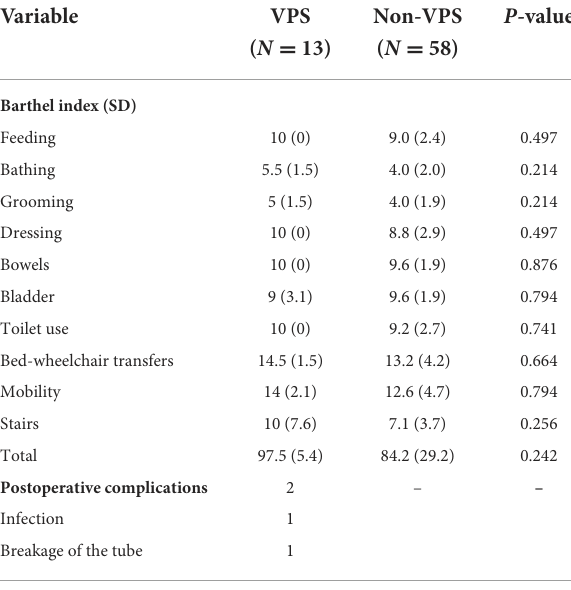
TABLE 2 The short-term outcomes of VPS and non-VPS patients. Variable